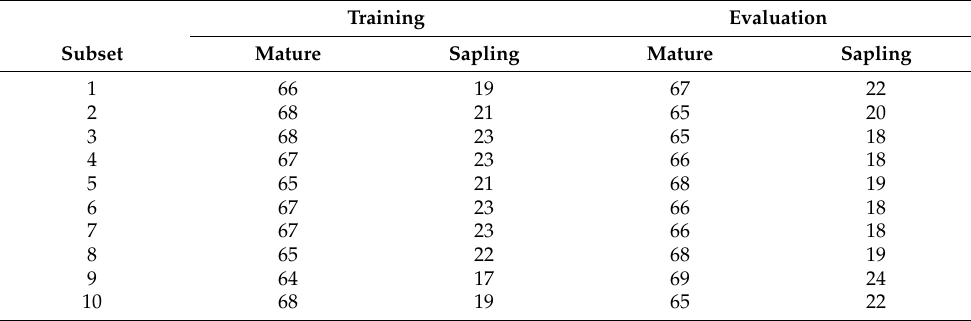
Table A2. Number of presences in the life stages (mature and sapling) selected in each of the 10 iterations of the SDMs. Of the 141 sampling points recorded in the Baetic System, 70 samples were randomly selected to calibrate the model in each iteration, while a further 70 were chosen for the